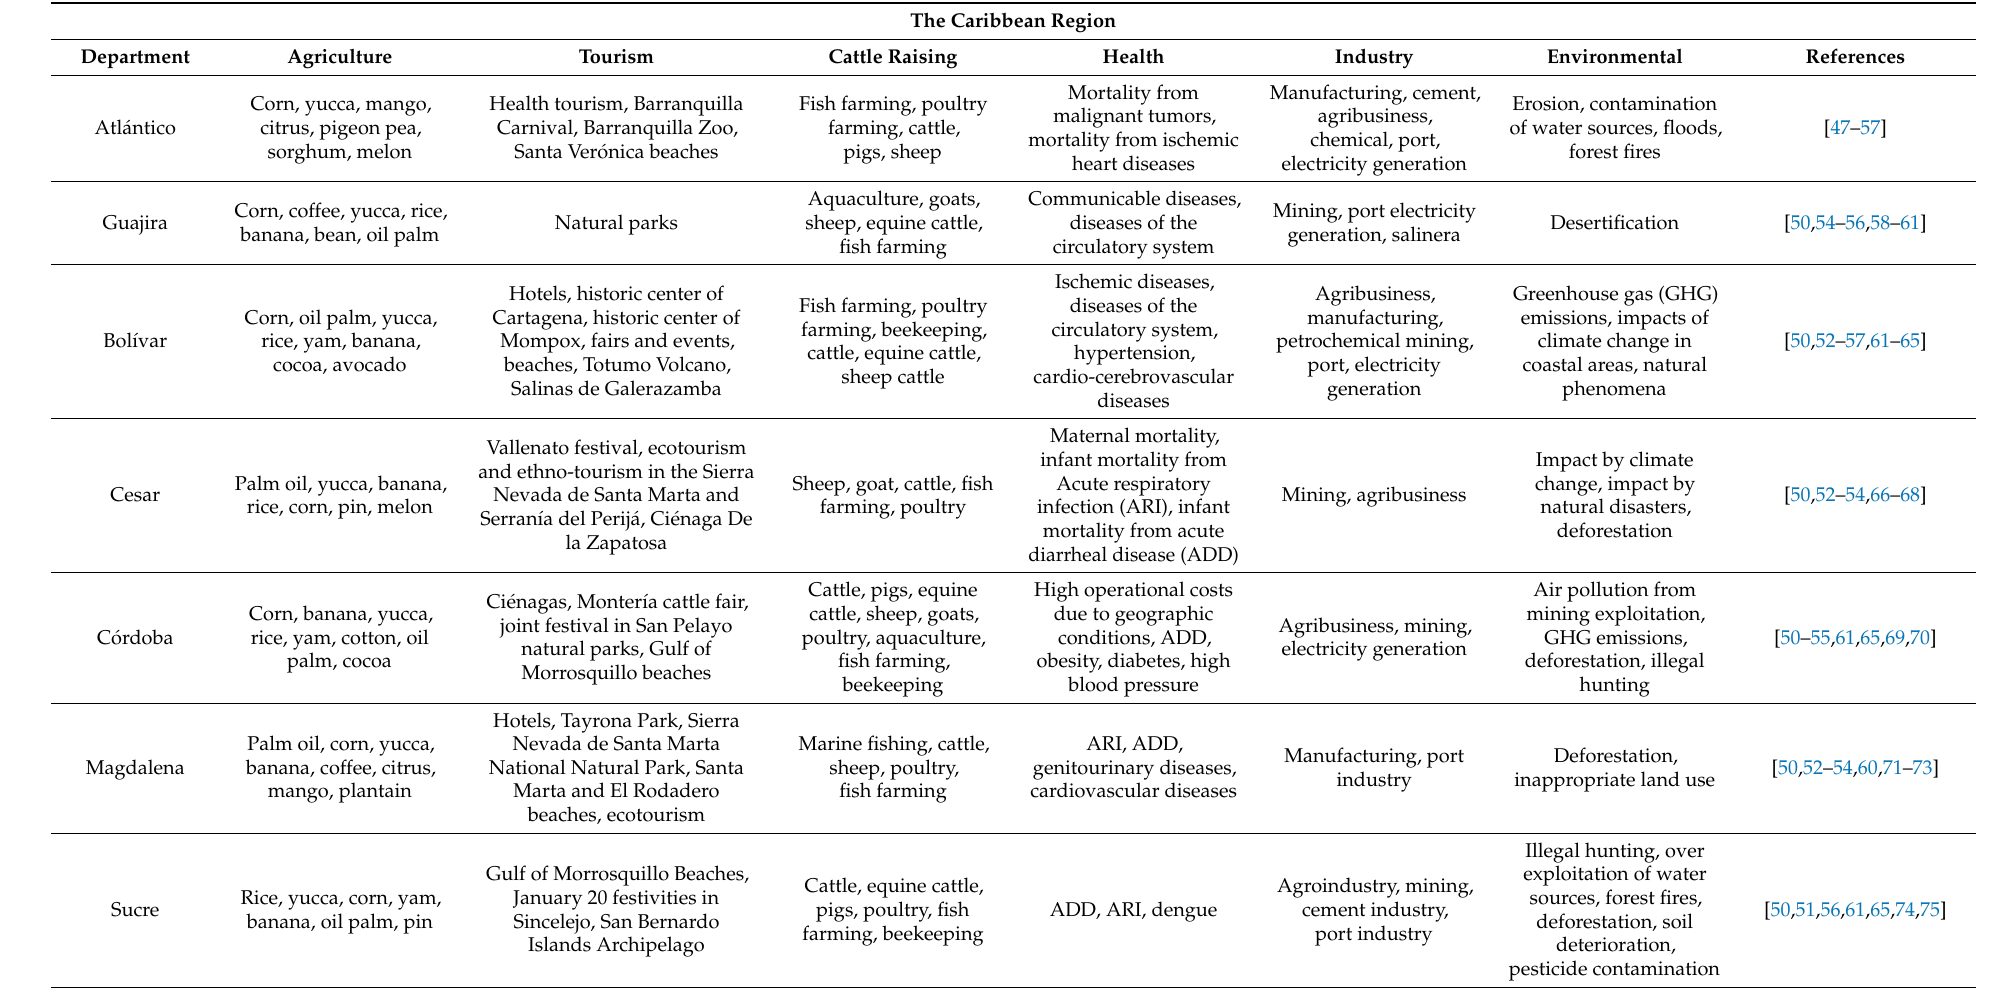
Table 4. Economic activities, problematics, and potentialities of Colombia departments. The Caribbean